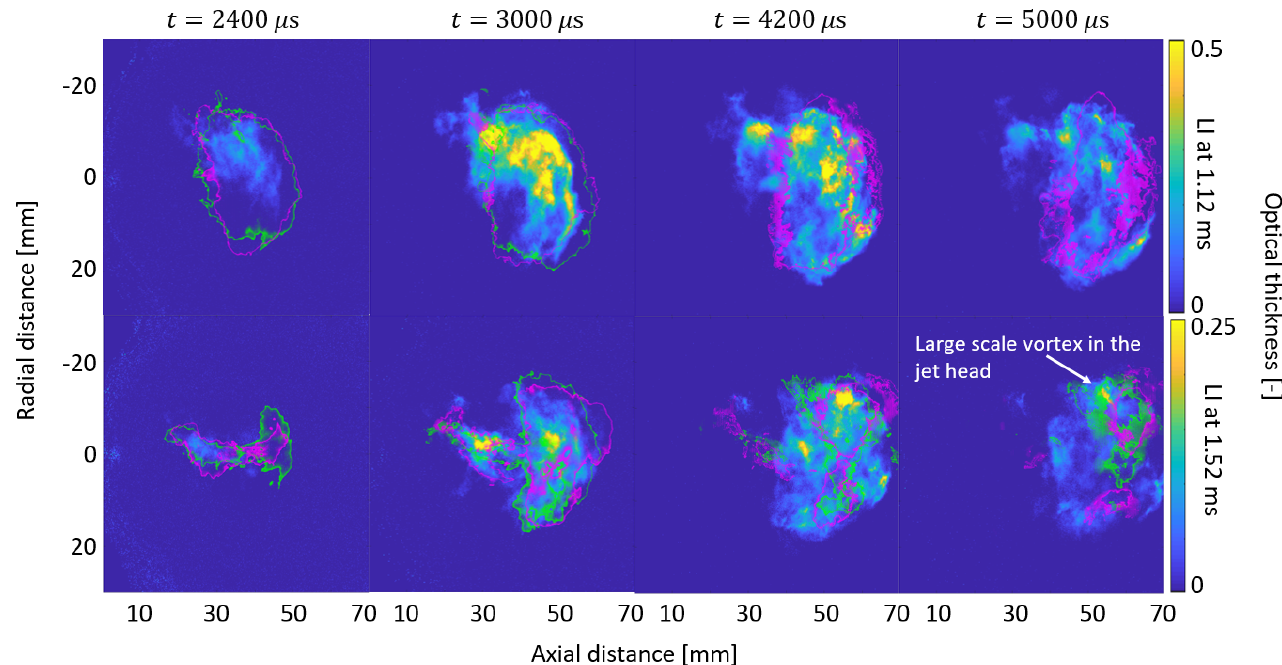
Figure 10. The color scale shows the ensemble-averaged optical thickness from the experiments. The green and magenta isolines represent the soot cloud boundary from LES. The green and magenta colors allow to identify different